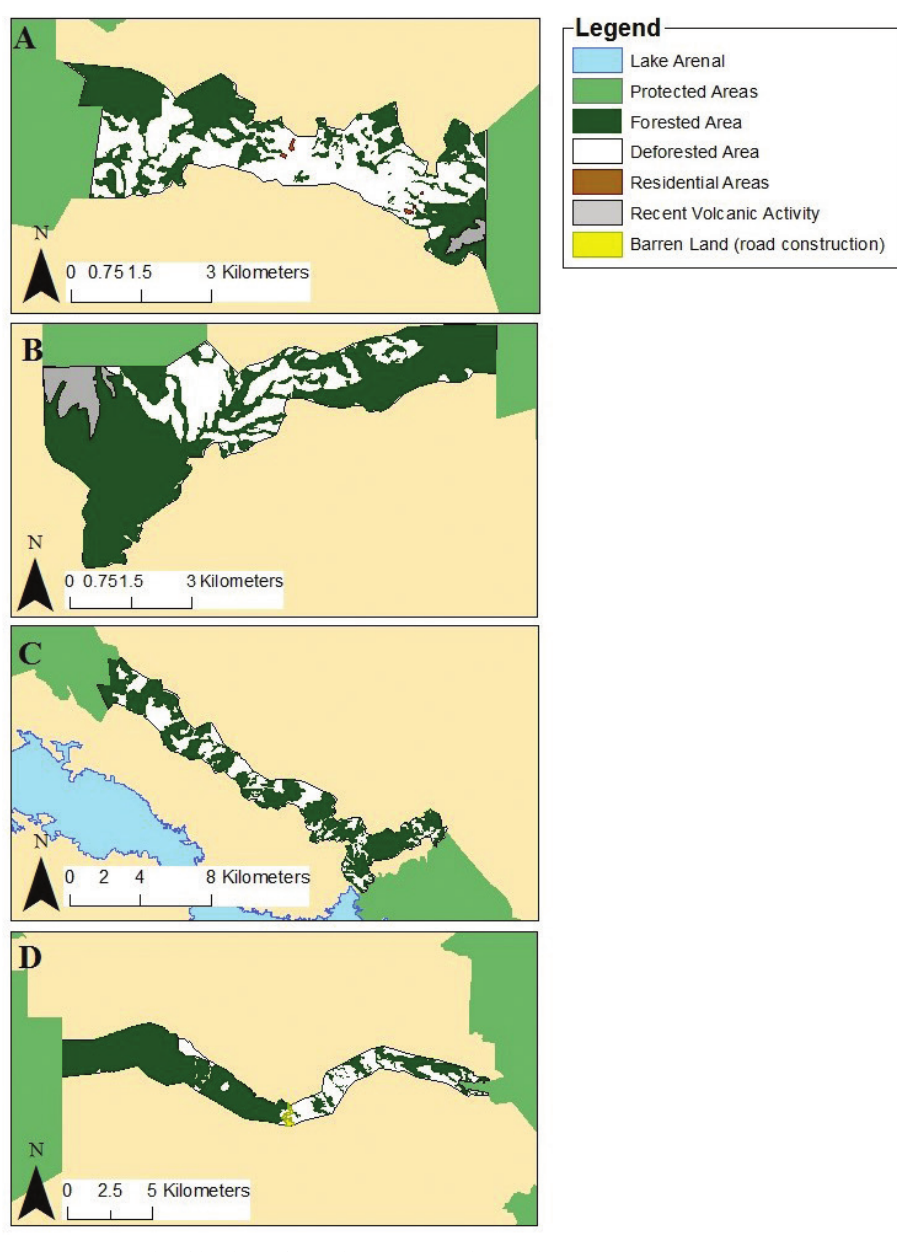
Figure 3. Details of land use for each proposed sub-corridor. A Guanacaste – Miravalles B Mirav- alles – Tenorio C Tenorio – Monteverde-Arenal Bioregion D Monteverde-Arenal Bioregion – Central Volcanic Mountain